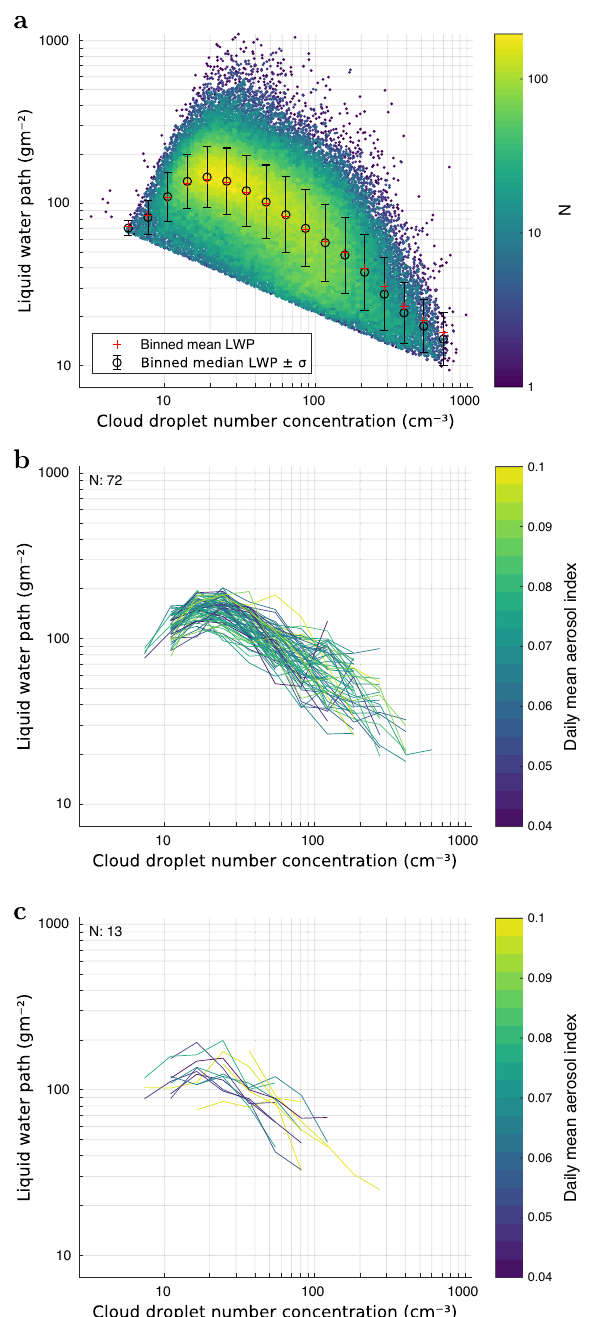
Fig.1|Liquidwaterpath(LWP)vsclouddropletnumberconcentration(CDNC) relationships obtained from satellite data over decreasing spatiotemporal scales. Similar increasing and then decreasing paired LWP vs CDNC relationships are observed in all cases indicating that processes occurring at small spatio- temporalscalesarecausingtherelationships.Panel a showsa2DhistogramofLWP and CDNC 1×1° daily datapoints taken over 1825 days for the whole of the Paci fi c North region (20 – 35° N, 110 – 150° W; ocean only) with colors showing the number of datapoints and the circles/bars showing the mean LWP±the standard deviation for speci fi c CDNC bins. Panel b shows LWP binned by CDNCfor the same area and period, but now using only daily snapshot data for each line in order to limit meteorological variability over time. Additionally, the daily standard deviation of the Aerosol Index is limited to below 0.04 in order to limit the impact of aerosol changesontheobservedrelationships.Nshowsthenumberofdaysintheplotand only those days are shown for which the number of datapoints N day exceeds 150. Only those points are shown for which the number of datapoints per CDNC bin exceeds 4. Lines are colored by the area mean AI. Panel c shows the same as for b exceptthatamuchsmallerregion(5×5°)isusedinordertolimitmeteorological variability, and thresholds N day >100 and NB>3 are used. MODIS data aggregated to 0.25×0.25° scale was used in c to increase the number of